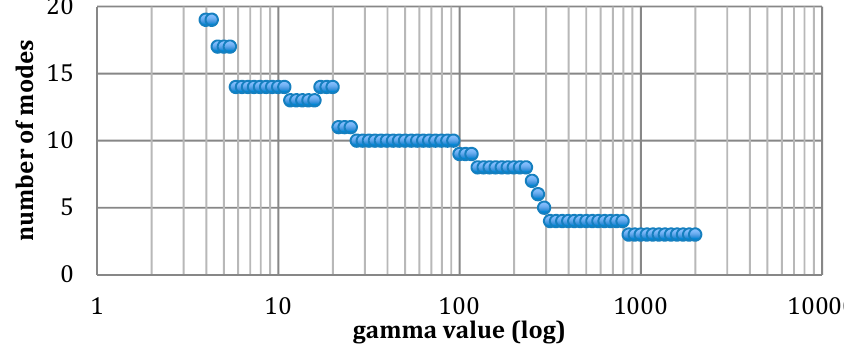
Figure 3. Permeability and porosity of single-phase reservoir model.